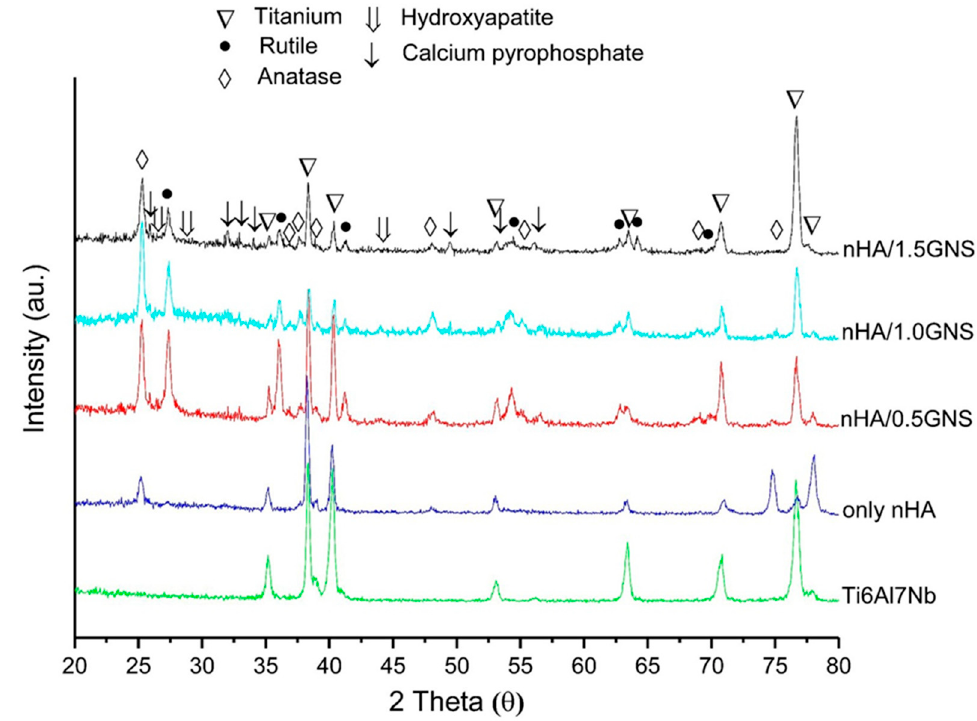
Figure 1. XRD patterns of the nHA/GNS coated and uncoated Ti6Al7Nb